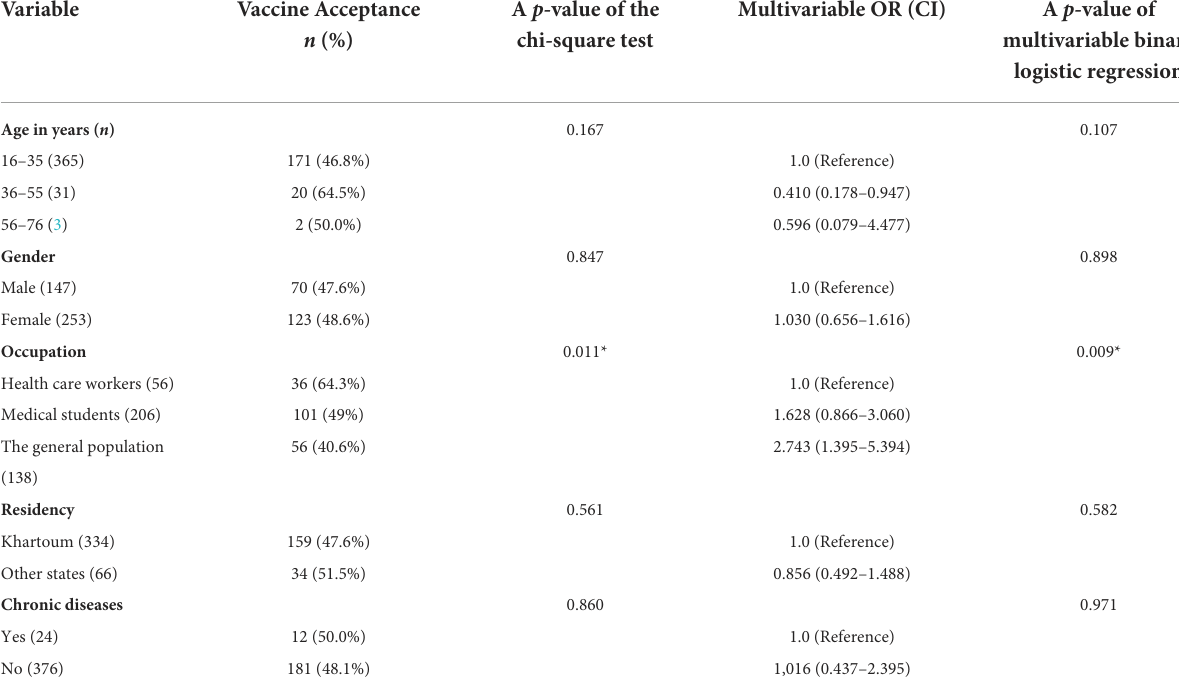
TABLE 4 Sociodemographic determinants of vaccine acceptance.